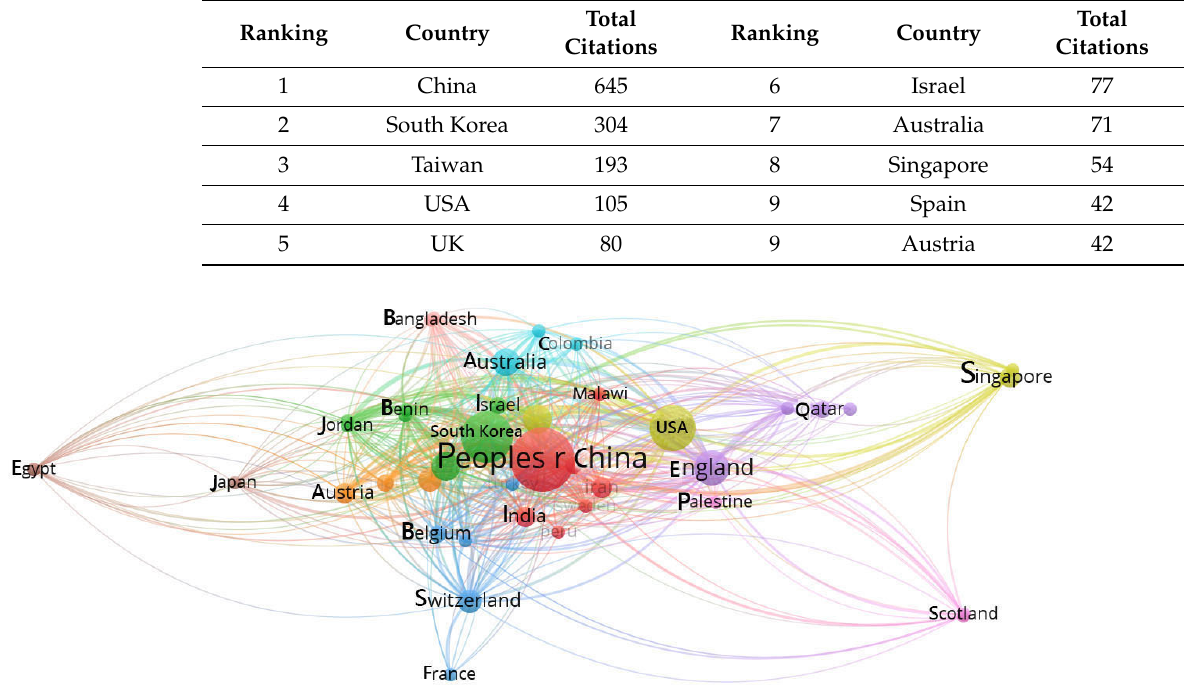
Figure 7. Bibliographic coupling of countries.